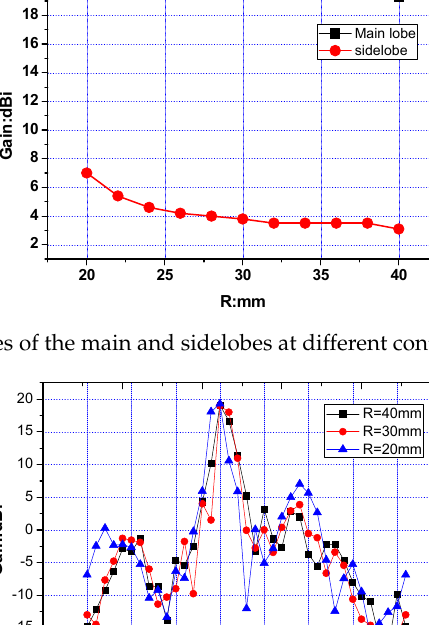
Figure 8. Rays on the longitudinal parabola ( a ) 2D diagram ( b ) 3D diagram.